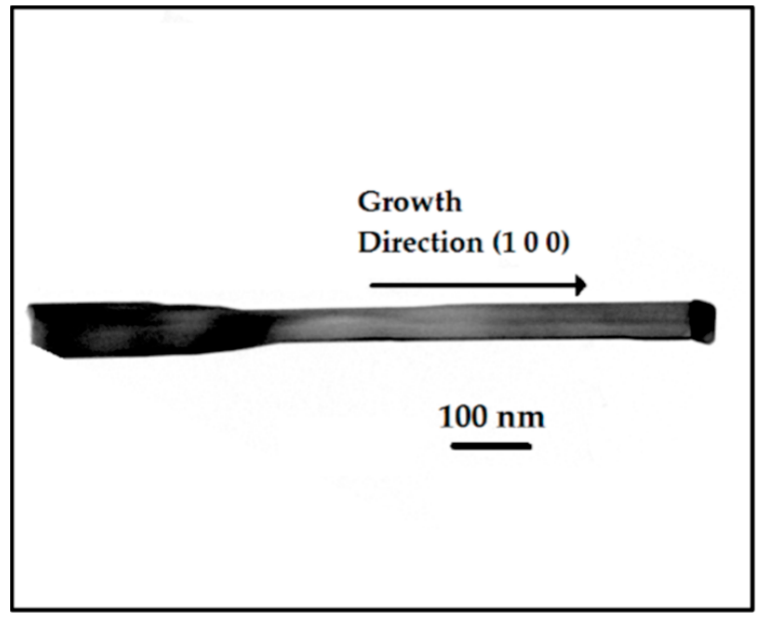
Figure 4. TEM image of a NW from Sample A, with an indication of its growth direction.